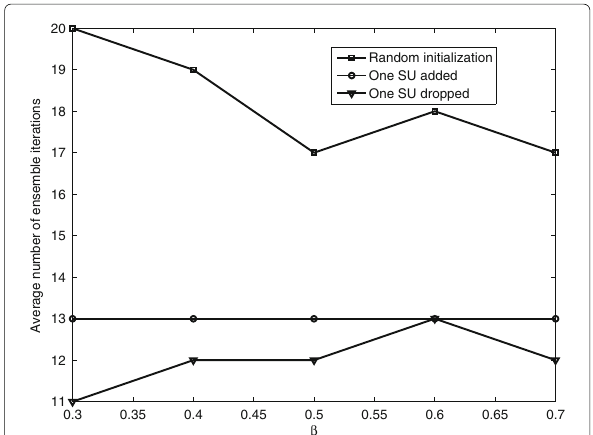
Fig. 10 The average number of ensemble iterations for convergence to the optimal NE for varying β and fixed μ = 0.5